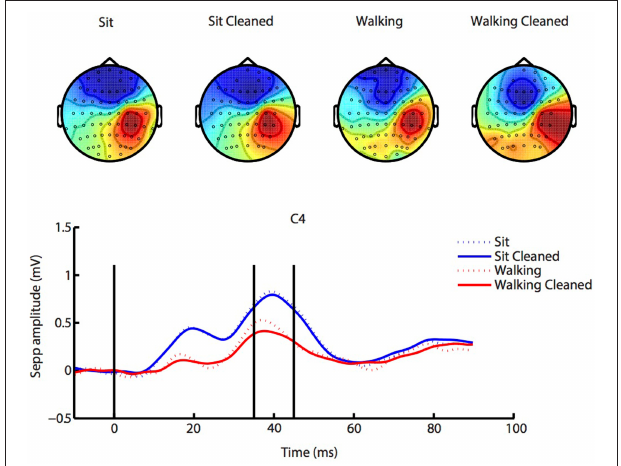
FIGURE 3 | SEP analysis. Similar SEP responses and accompanying scalp maps (from 35 to 45ms post stimulus, indicated by vertical lines) were present during both sitting (blue lines) and walking (red lines), and our ICA cleaning procedure changed SEP amplitude only little (solid lines; cleaned), while clearly improving the scalp map. See Supplementary Figures 1 – 4 for source localization of SEP activity.